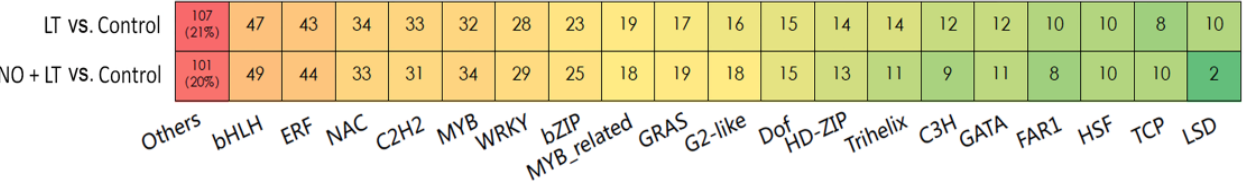
Figure 5. The types and numbers of TF families in the DEGs obtained by LT vs. Control and NO + LT vs. Control, respectively. Color changes represent the changes in gene number. Table 1. The upstream transcription factors (TFs) enrichment results.